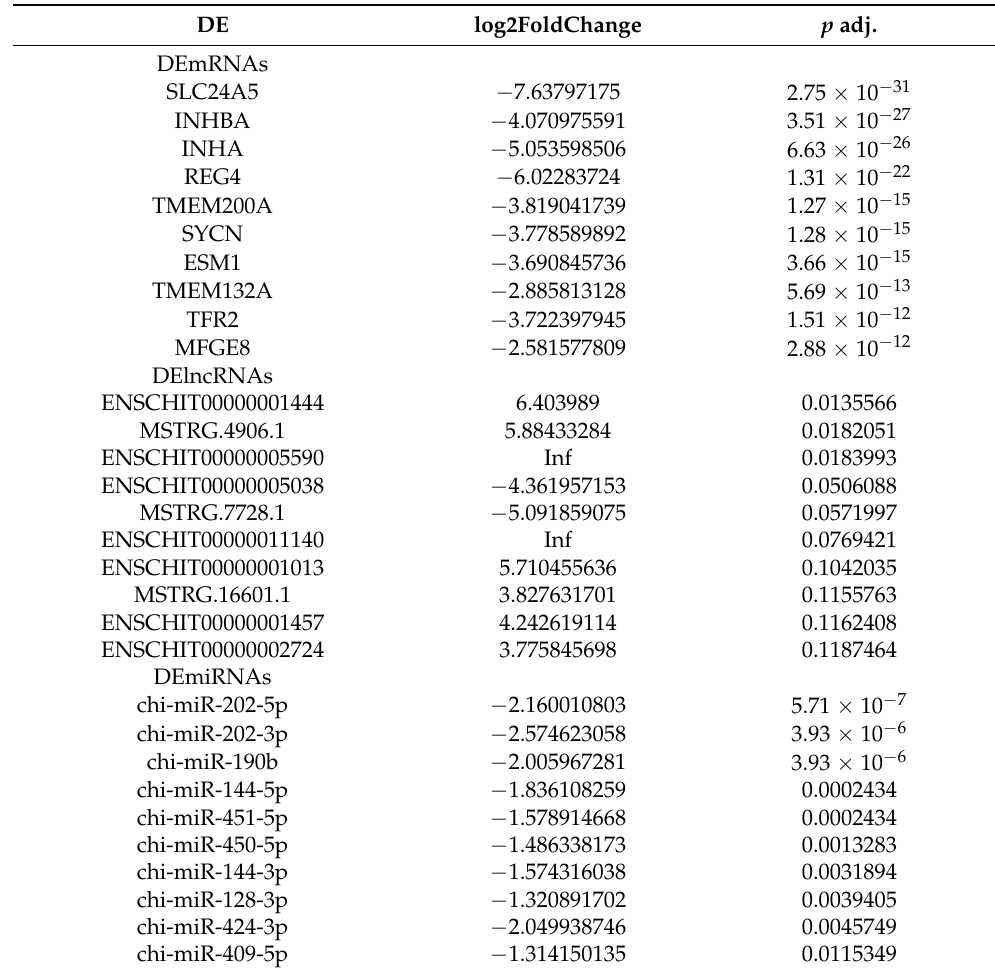
Table 2. The top ten DEmRNAs, DElncRNAs, and DEmiRNAs were found to be significantly different between large and small